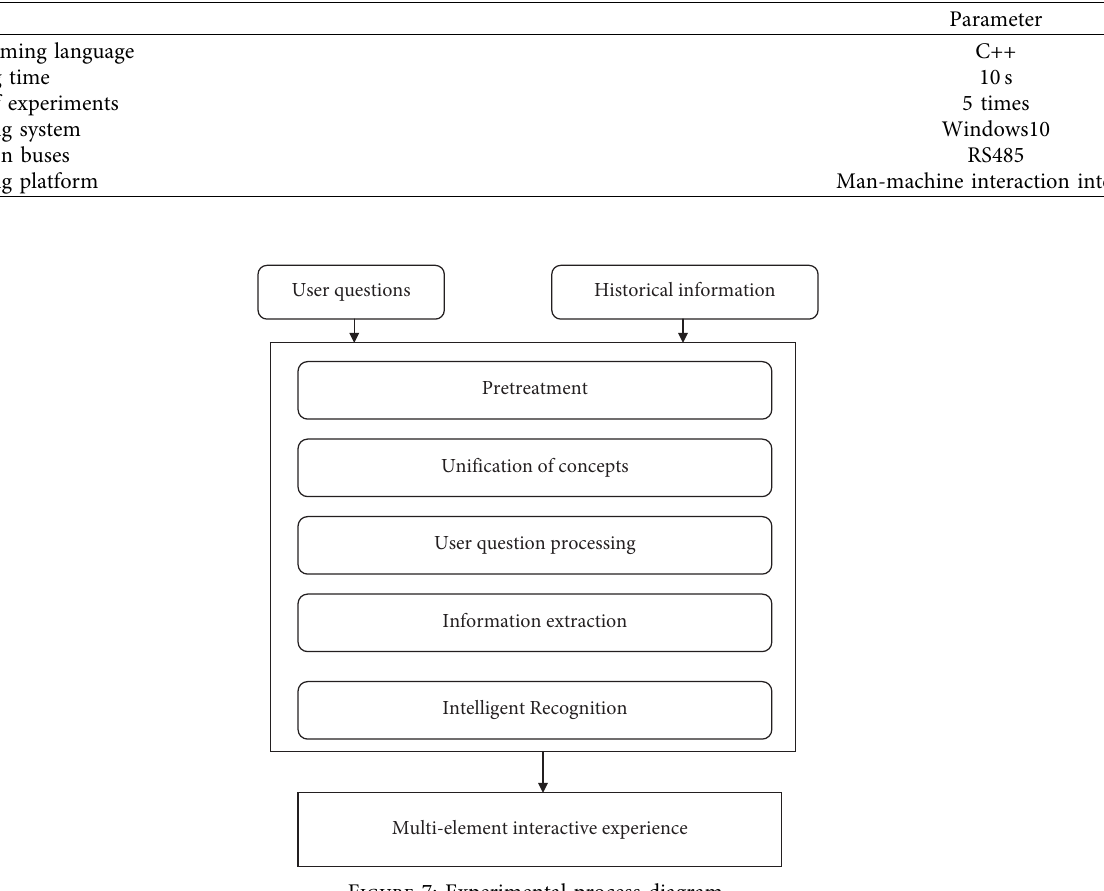
Figure 6: The difference between traditional design and product requirements of modern design. Table 1: Experimental environment.